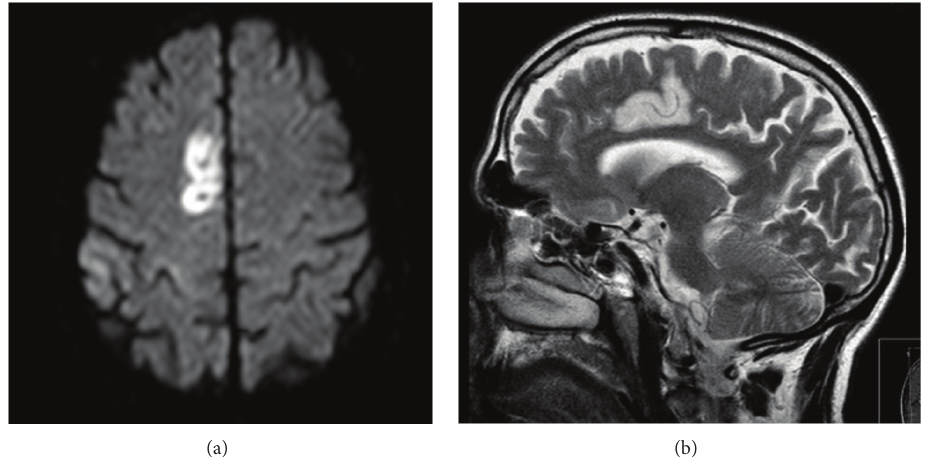
Figure 2: (a) Diffusion-weighted image and (b) T2-weighted image: acute ischaemic lesion on the inner surface of the frontal lobe, extending to the right cingulate